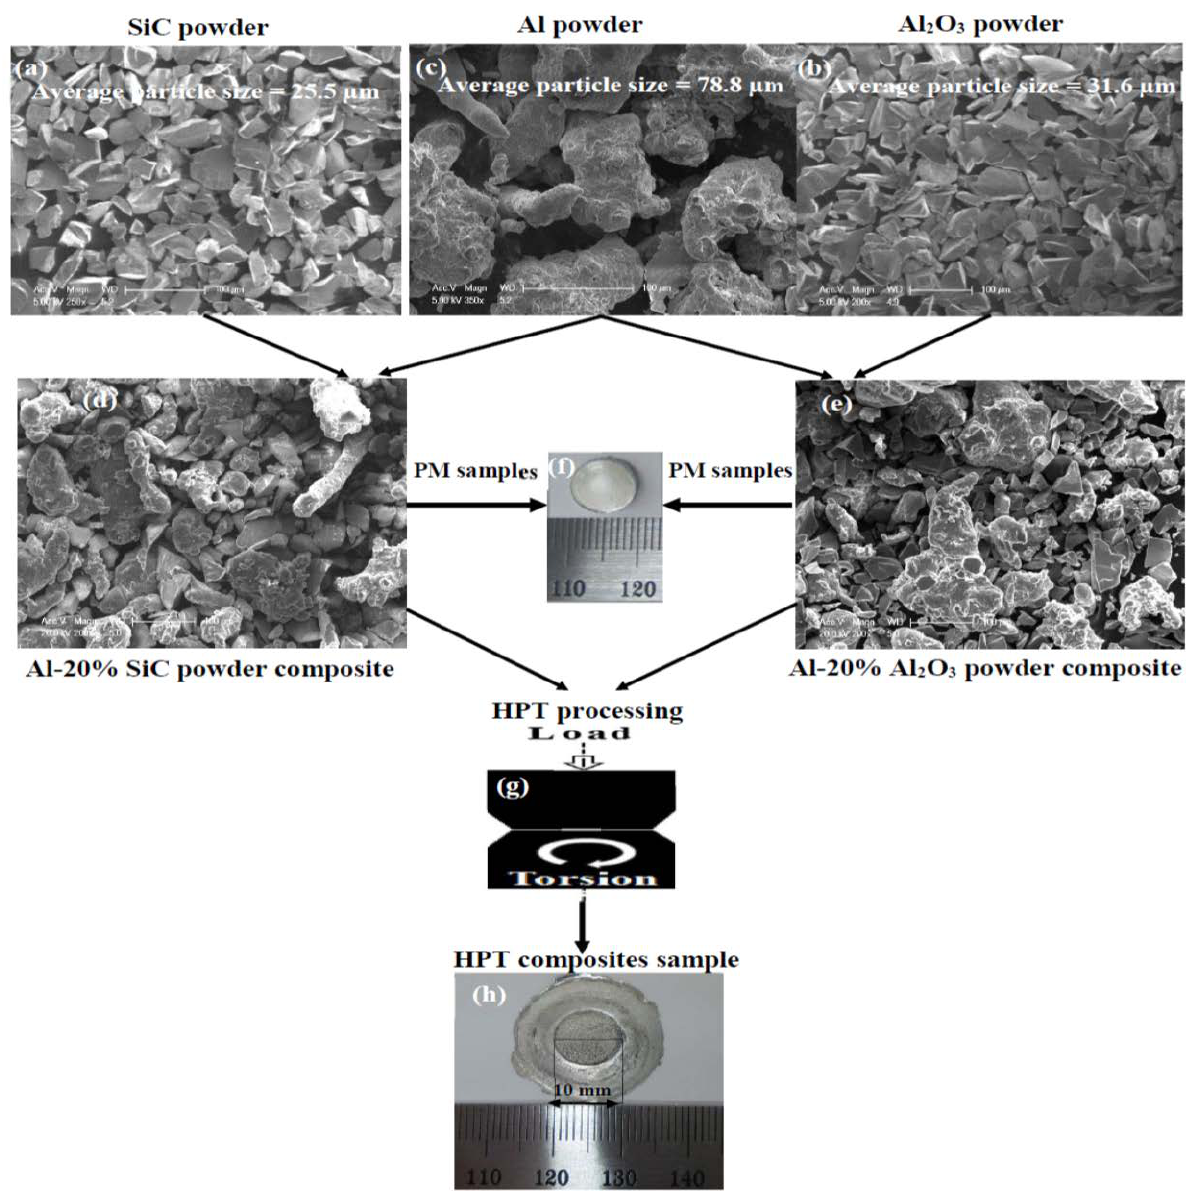
Figure 1. The PM and HPT processing diagram of Al-Al 2 O 3 and SiC composites powder sample. The samples were prepared to measure the experimental density using METTLER TOLEDO’s XS204 device. Moreover, the values of the theoretical densities were obtained through the rule of the mixture [1]. Therefore, the relative density (which indicates the degree of the densification and the void% content) was calculated based on equations previously used